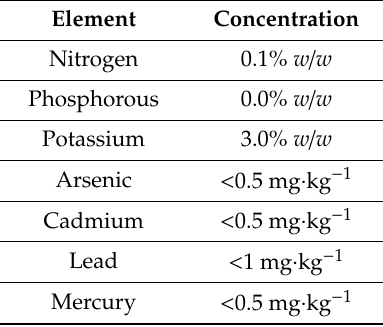
Table 3. Foliar organic stimulant composition (based on marine algae Ascophyllum nodosum